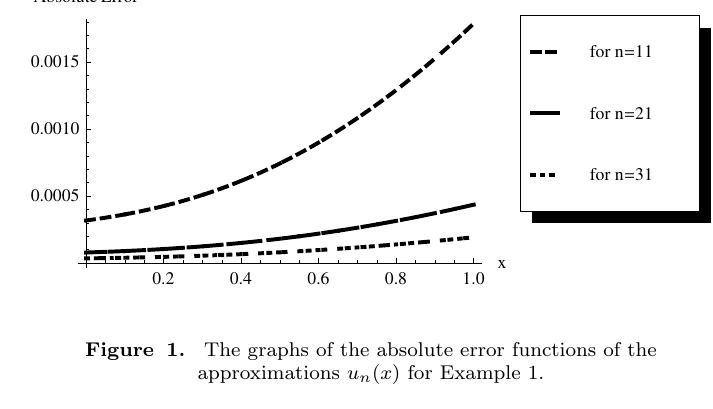
Figure 1. The graphs of the absolute error functions of the approximations u n ( x ) for Example